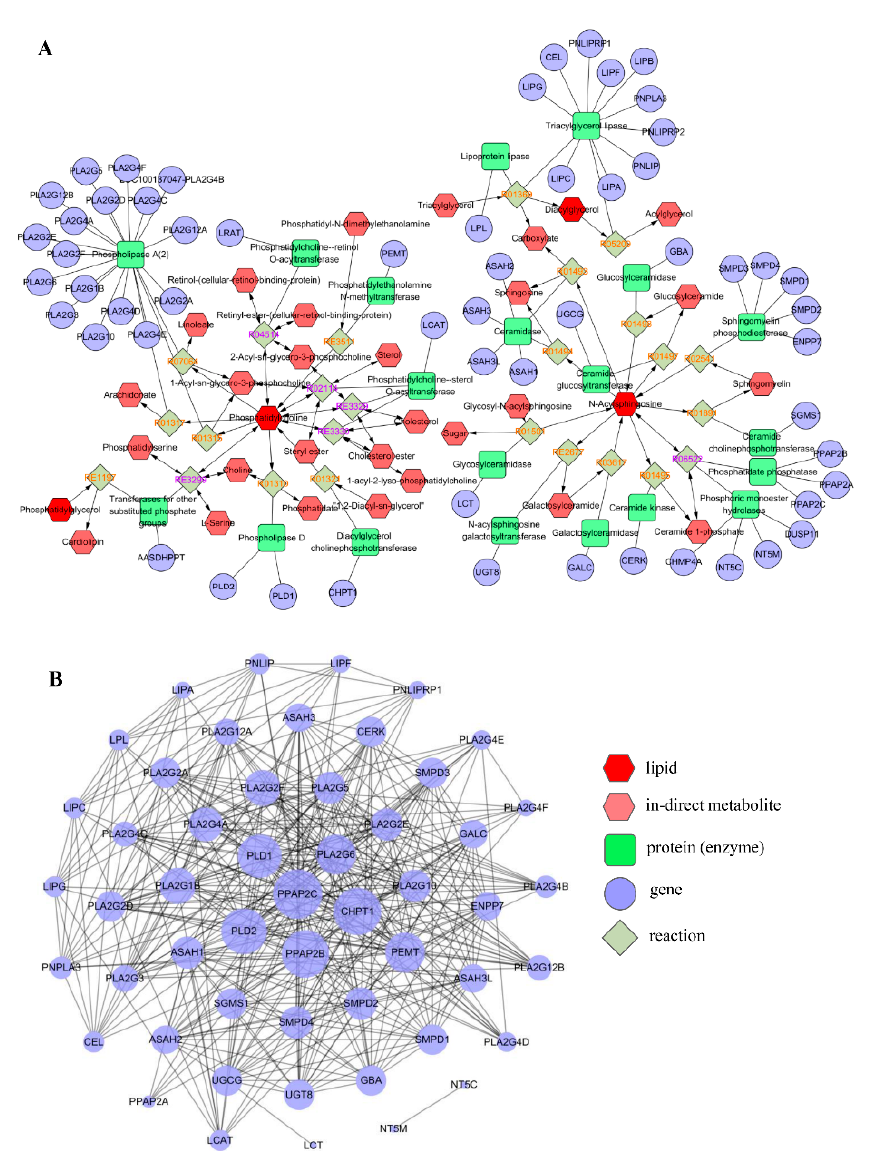
Figure 9. ( A ) The lipids ‒ reaction ‒ enzyme ‒ gene interaction network. The red hexagon represents differential lipids; the pink hexagonal represents in-direct metabolites. The green square represents protein (enzyme). The purple circle represents genes that code for the protein. ( B ) Protein ‒ protein interaction network on the targets potentially responsible for the altered lipid metabolism during CRE infection.